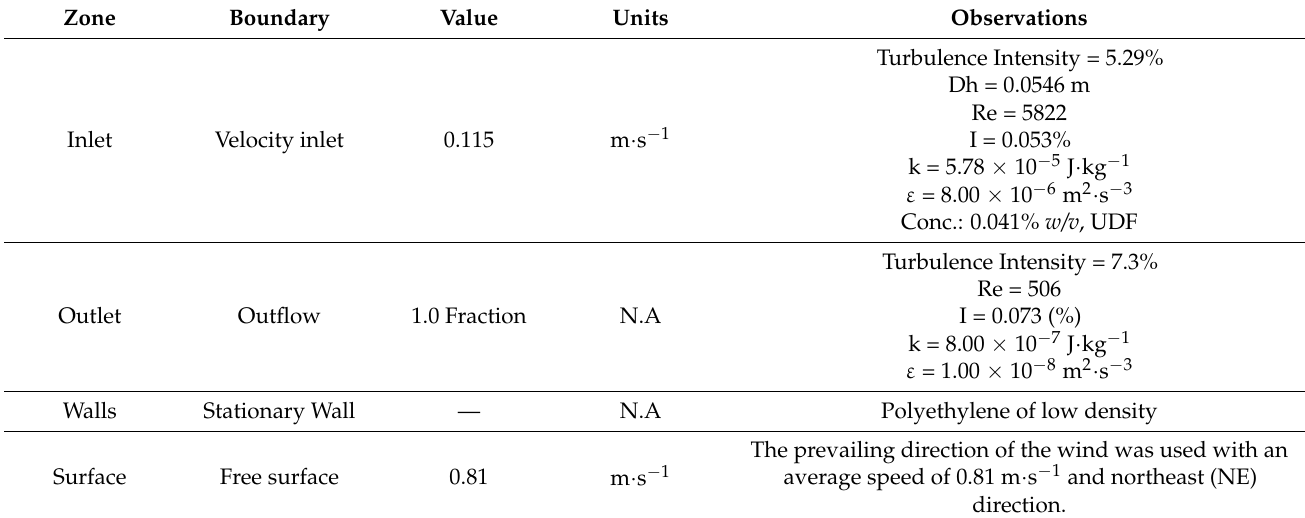
Table 1. Boundary conditions used in CFD